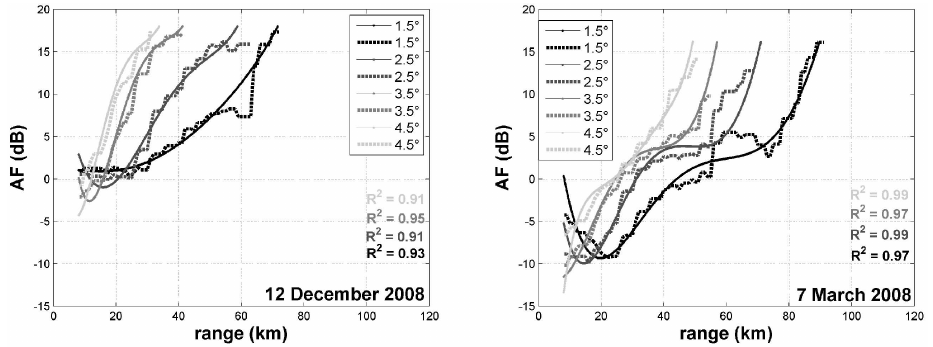
Fig. 6. AF trends with range carried out for the 12 December 2008 and the 7 March 2008 stratiform events, computed by using both a polynomial fit of the fifth order (solid lines) and a method of moving averages with a window of 15km (dashed curves). Curves are obtained for different elevation angles ranging from 1.5 to 5.5 ◦